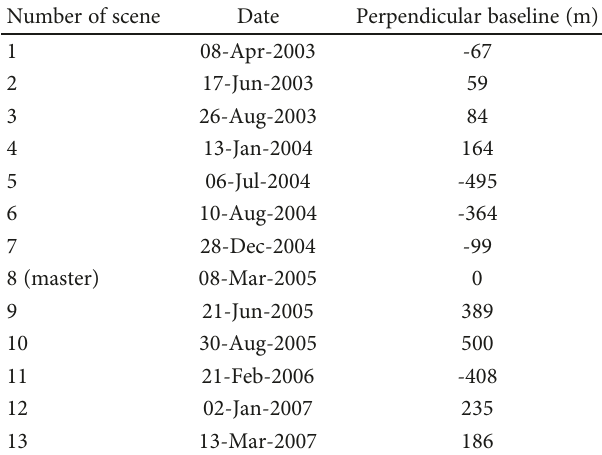
Figure 1: Simpli fi ed geological map of the Los Humeros Geothermal Field and its surroundings, highlighting major faults, the caldera rims, and the location of the wells. Modi fi ed after Norini et al. [11] and Carrasco-Núñez et al. [12] . Table 1: List of scenes that were used for PS-InSAR processing acquired on descending orbits, track